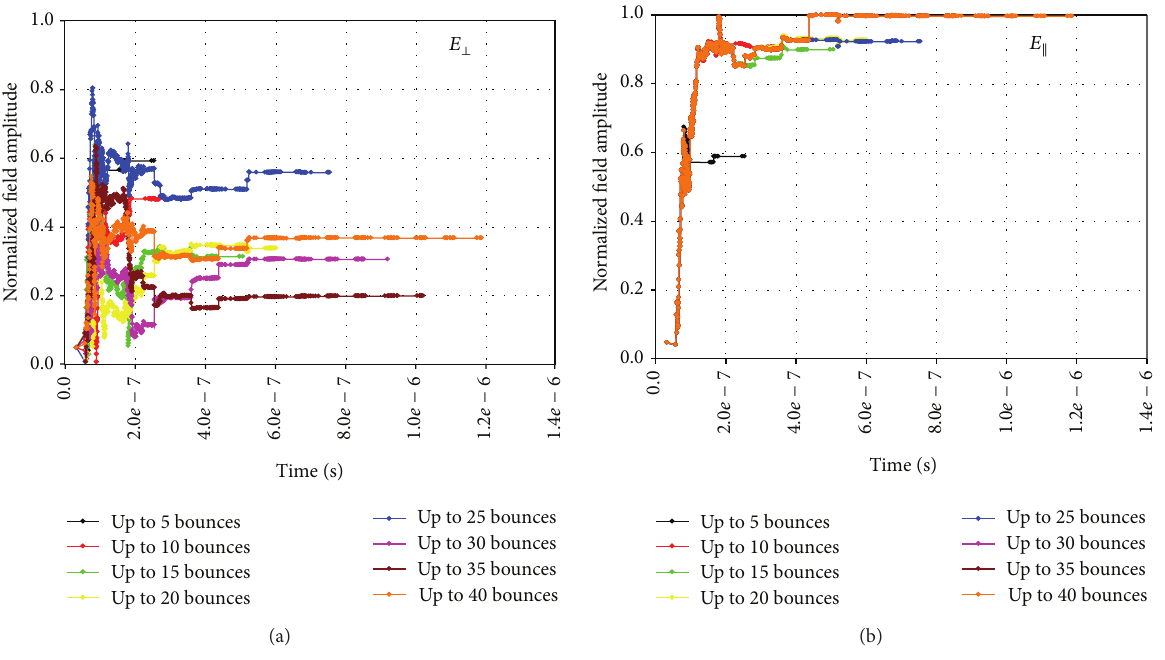
Figure 6: (a) RF field build-up inside a metallic space vehicle. Frequency = 6 GHz; 𝜎 = 1.8 × 10 5 S/m, polarization: perpendicular . Since the walls of space vehicle are metallic, convergence has not been achieved. (b) RF field build-up inside a metallic space vehicle. Frequency = 6 GHz; 𝜎 = 1.8 × 10 5 S/m, polarization: parallel. Since the walls are metallic, convergence has not been